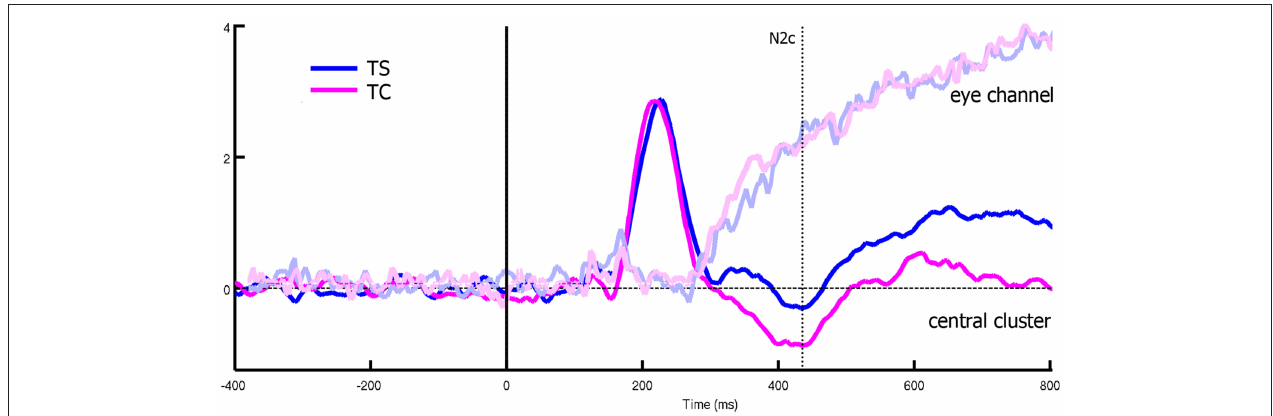
FIGURE 5 | Differences between eye channel and central cluster within translating conditions, considering all the subjects. While the two eye-channel traces overlaps, central cluster one showed a significant deviation that cannot be thus related to eye muscles effects.